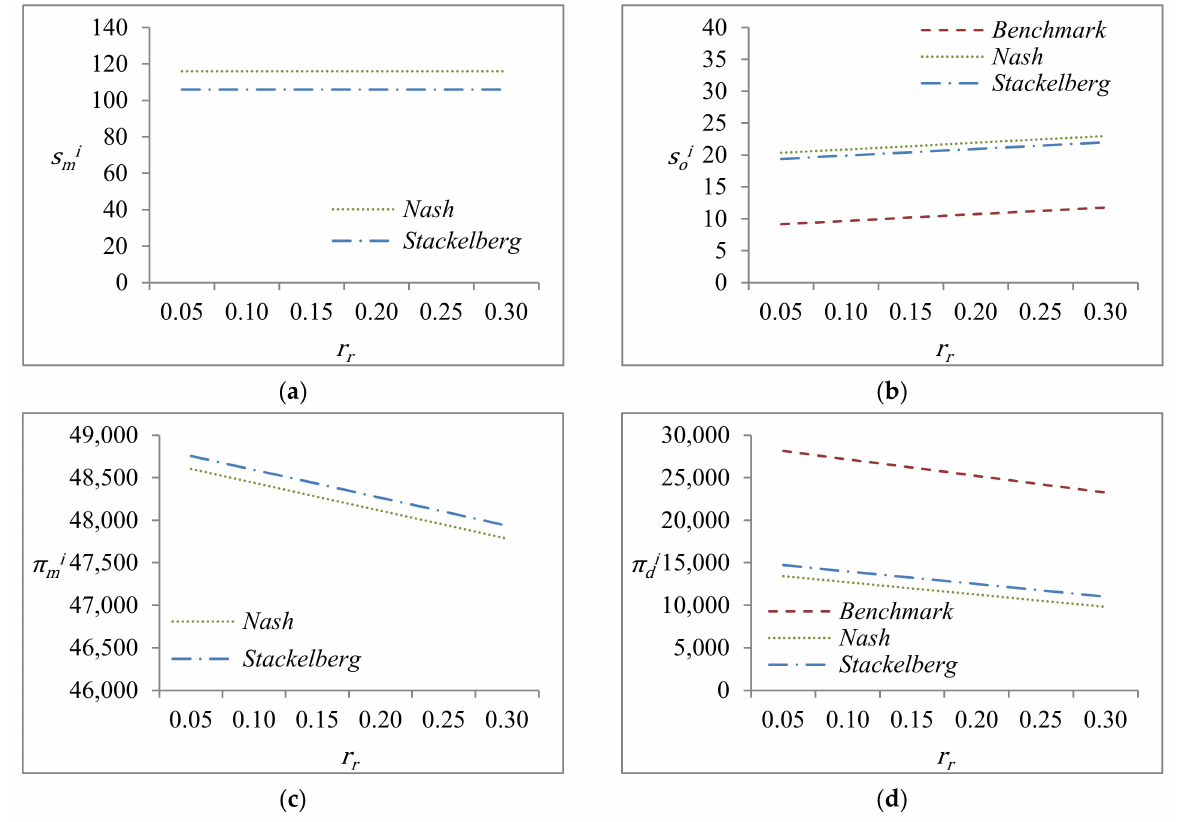
Figure 3. Effect of physical stores’ rate of return on: ( a ) manufacturer’s decision; ( b ) retailer’s decision; ( c ) manufacturer’s profit; ( d ) retailer’s profit. The following market condition is used: r = 0.2, r r = variable , ε = 0.005, h = 30, α m = α o = α r = 100, γ = 0.9, γ r = 0.2, p = 600, v r = 400, v o = 20, c d = 420, c m = 100, ∅ =